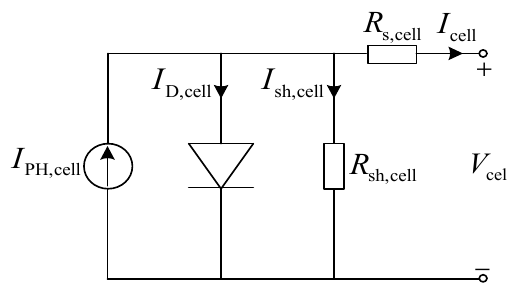
Figure 1. Single diode model of the solar cell.